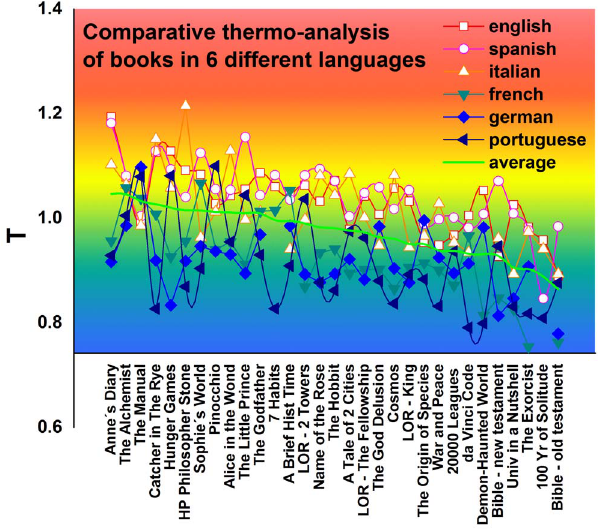
Figure 3. Temperature for books. Plot of characteristic temperature dependance of the language for several